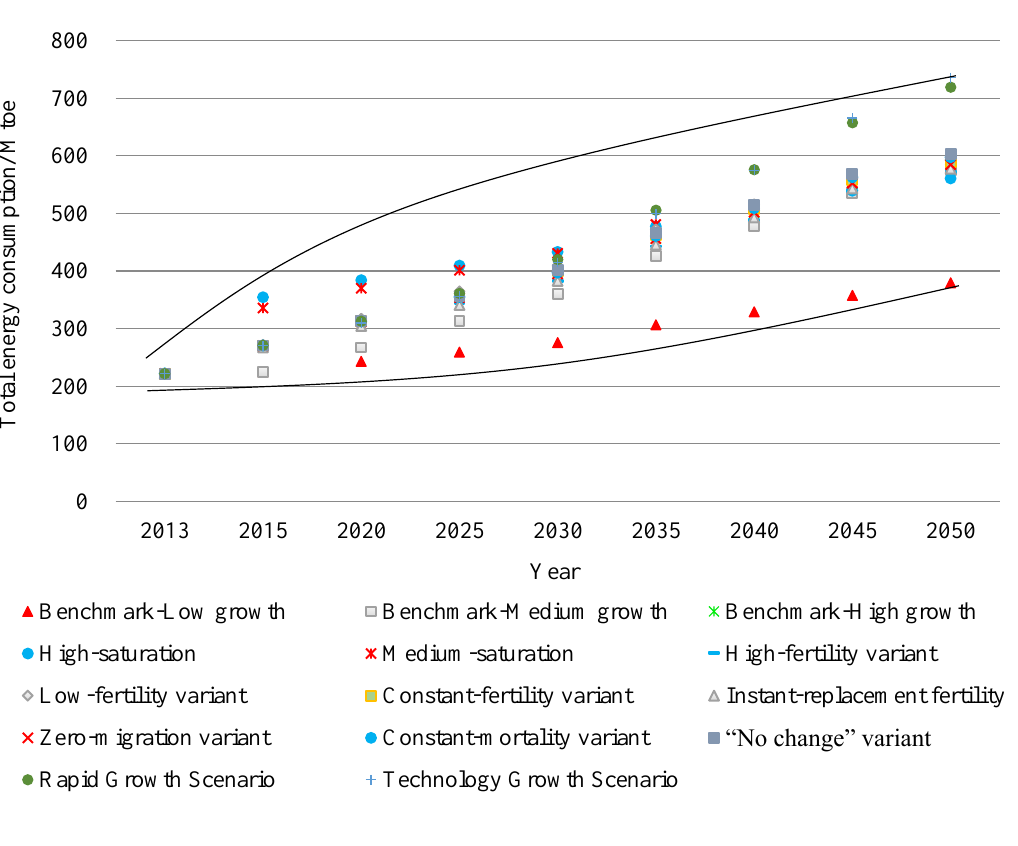
Figure 17. Total energy consumption of road vehicles under different